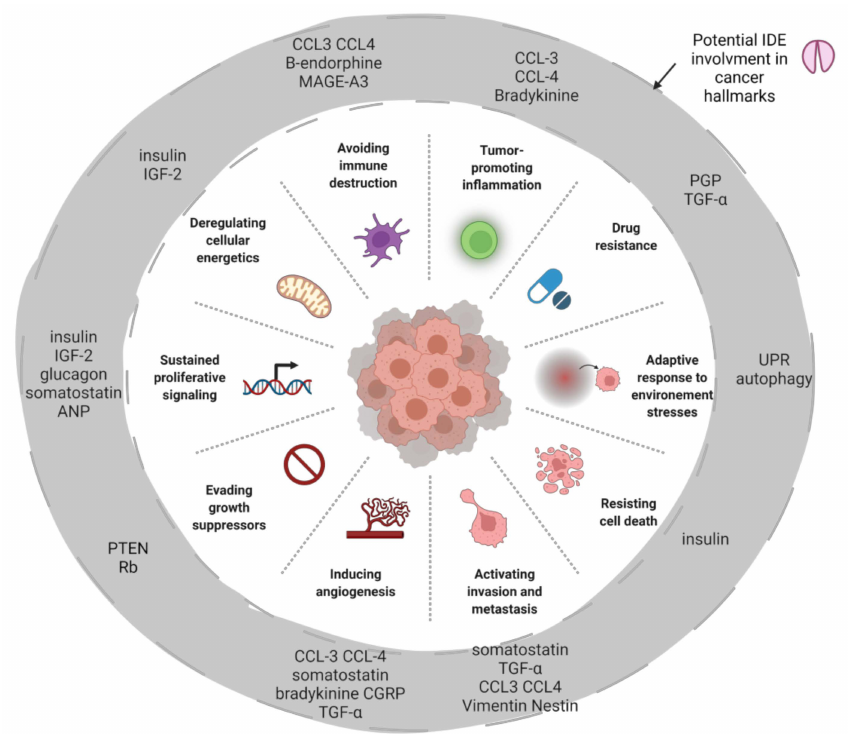
Figure 4. Potential IDE involvement in some cancer hallmarks by its substrates, its protein-protein interactions or by itself with its modulations. The main effect of substrates is reported and can act positively or negatively on cancer hallmarks (Table 1). Created with BioRender.com (31 March